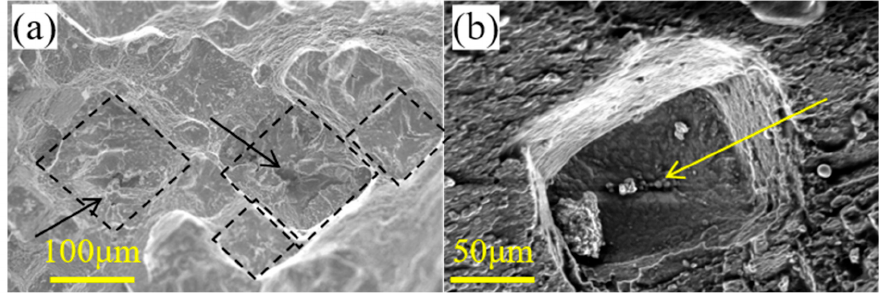
Figure 16. Detailed rupture morphology of the 1.2 mm thick thin-walled specimen. ( a ) The detailed morphology of the left part of one half of the specimen. ( b ) The detailed morphology of the cleavage plane.